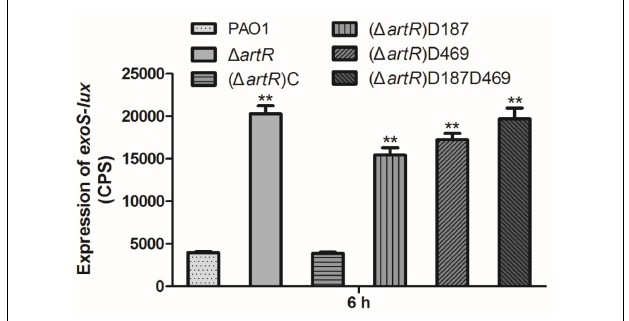
FIGURE 5 | Expression of exoS in PAO1 and artR point mutants. Strains carried reporter plasmid pKD- exoS were cultured under T3SS inducing conditions. Promoter activities were measured after 6 h growth. Error bars represent one standard deviation from the mean. ∗∗ p < 0.01 compared to the wild-type based on Student’s t